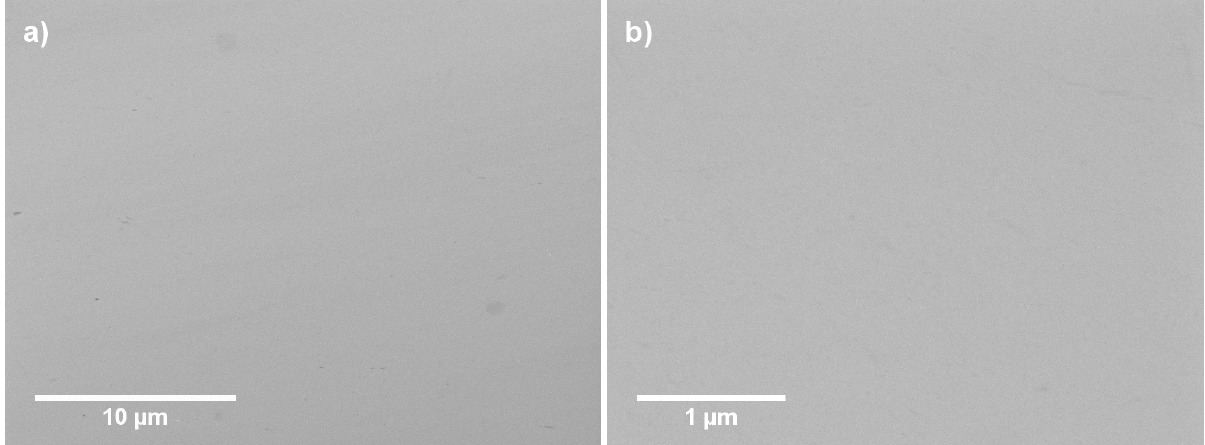
Figure 3. SEM images near the edge of the HPT disk. At low magnifications ( a ) and even at high magnifications ( b ), no cracks, pores or other inhomogeneities can be detected. At the edge of the same specimen (Figure 3), no cracks or pores can be detected. So, these SEM images confirm that full density is reached after sufficient deformation of the specimen. No other features are visible in the SEM images due to the absence of cracks, pores and boundaries. XRD and DSC measurements as well as TEM imaging were used to investigate the microstructure of the HPT deformed specimen. In XRD broad peaks are expected for an amorphous material,